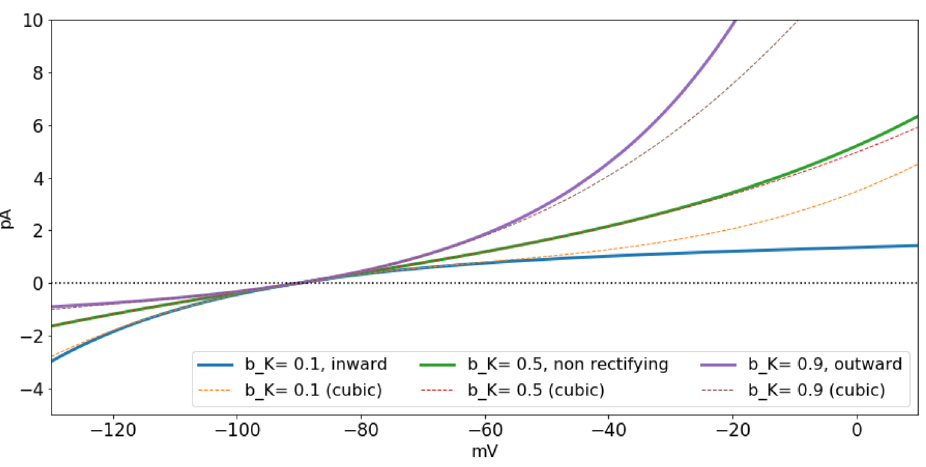
Figure 2. Currents mediated by K-electrodiffusion for b approximation (dashed lines). Inward rectification occurs for b